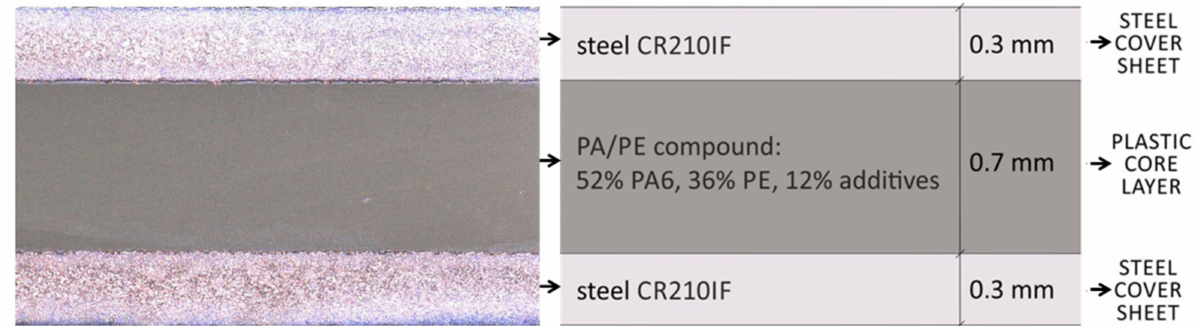
Figure 1. Overview of the MPC material Litecor ® used in this